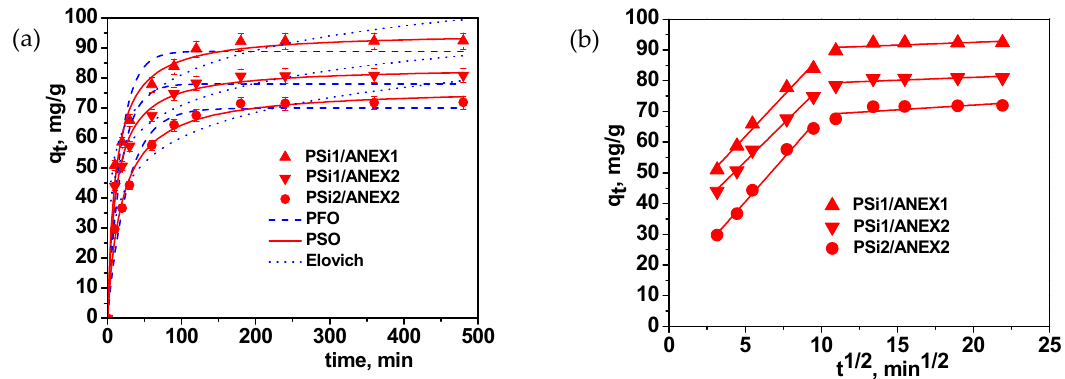
Figure 6. ( a ) Sorption kinetics of Cr(VI) onto PSi/ANEX composite microspheres fitted with three kinetic models: ( b ) Fitting IPD model on the sorption kinetics data of Cr(VI) onto the PSi/ANEX composites: sorbent dose 1 g/L; temp. 23 °C; initial pH 4.0; initial concentration of Cr(VI) 100 mg/L.